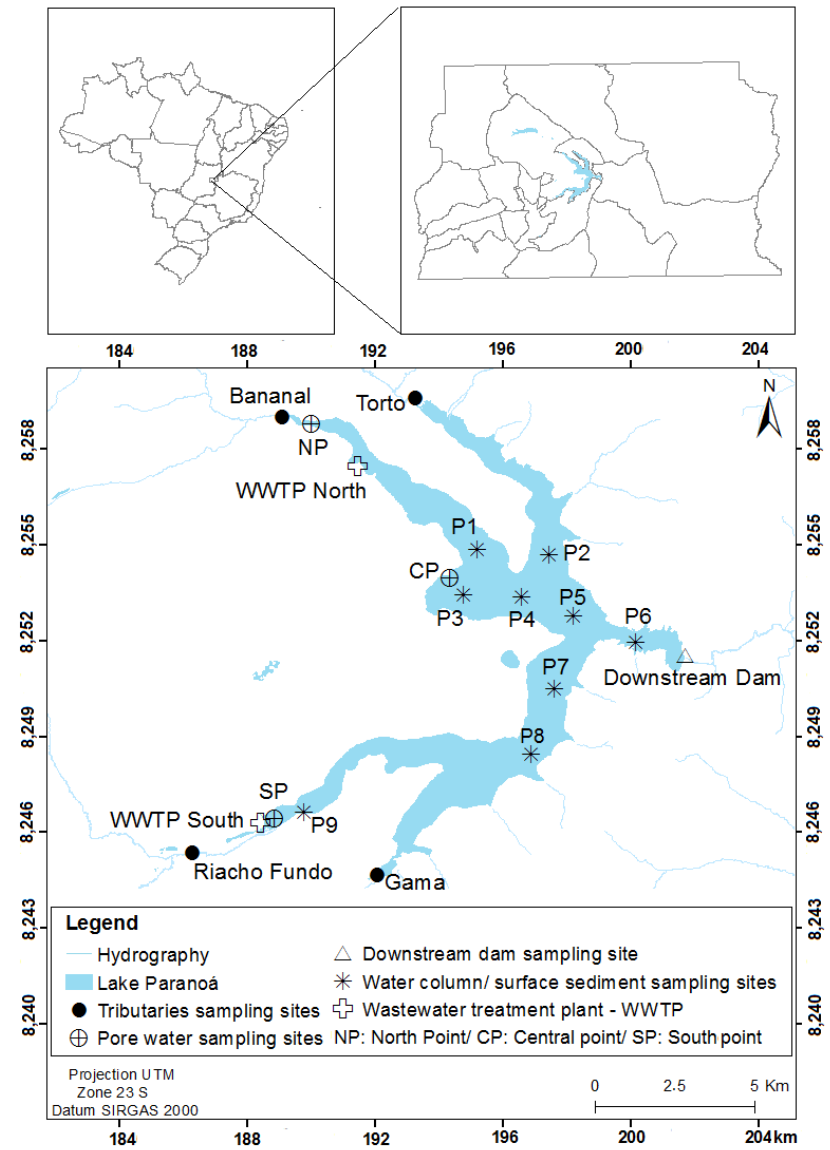
Figure 1. Localization of study area and sampling points.